Question: Name the type of graph shown.
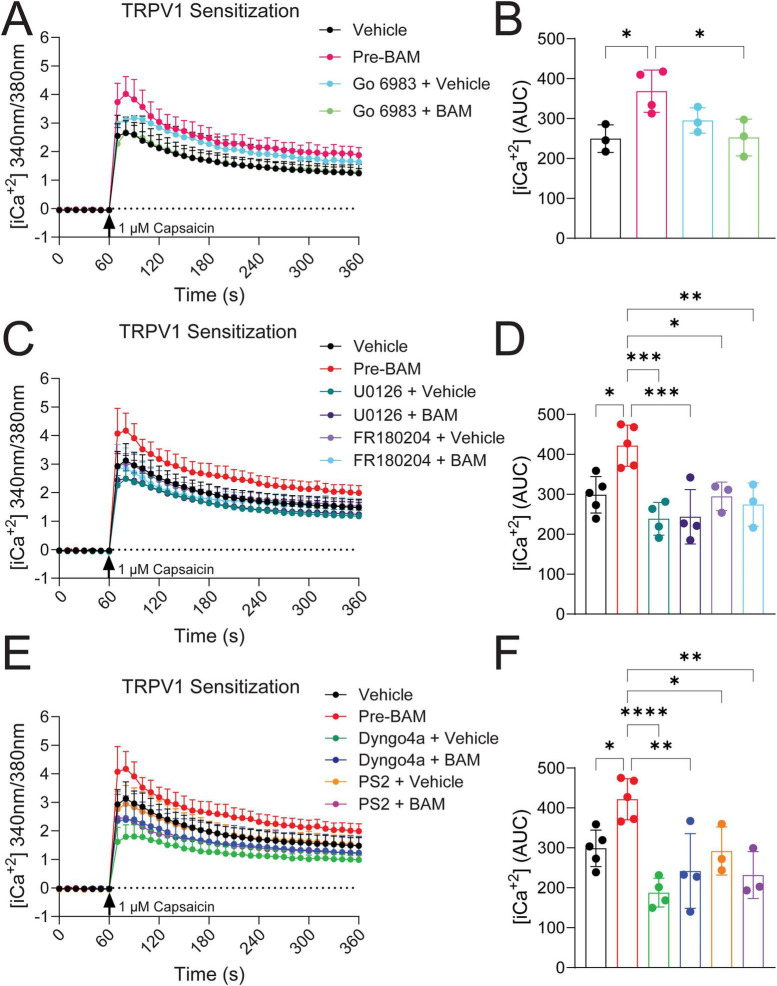
Answer: line